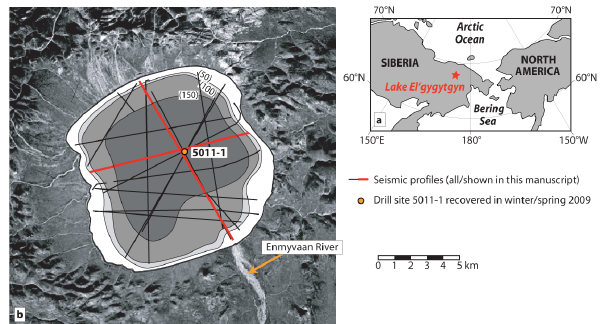
Fig. 1. Geographical map of the investigation area. (a) Location of Lake El’gygytgyn in NE Russia; (b) aerial photograph of the lake surroundings with lake bathymetry and seismic profiles. The profiles marked in red are shown in Figs. 2 and 3. The orange arrow marks the Enmyvaan River, the only outlet of the lake. Drill site ICDP 5011-1 is shown as an orange